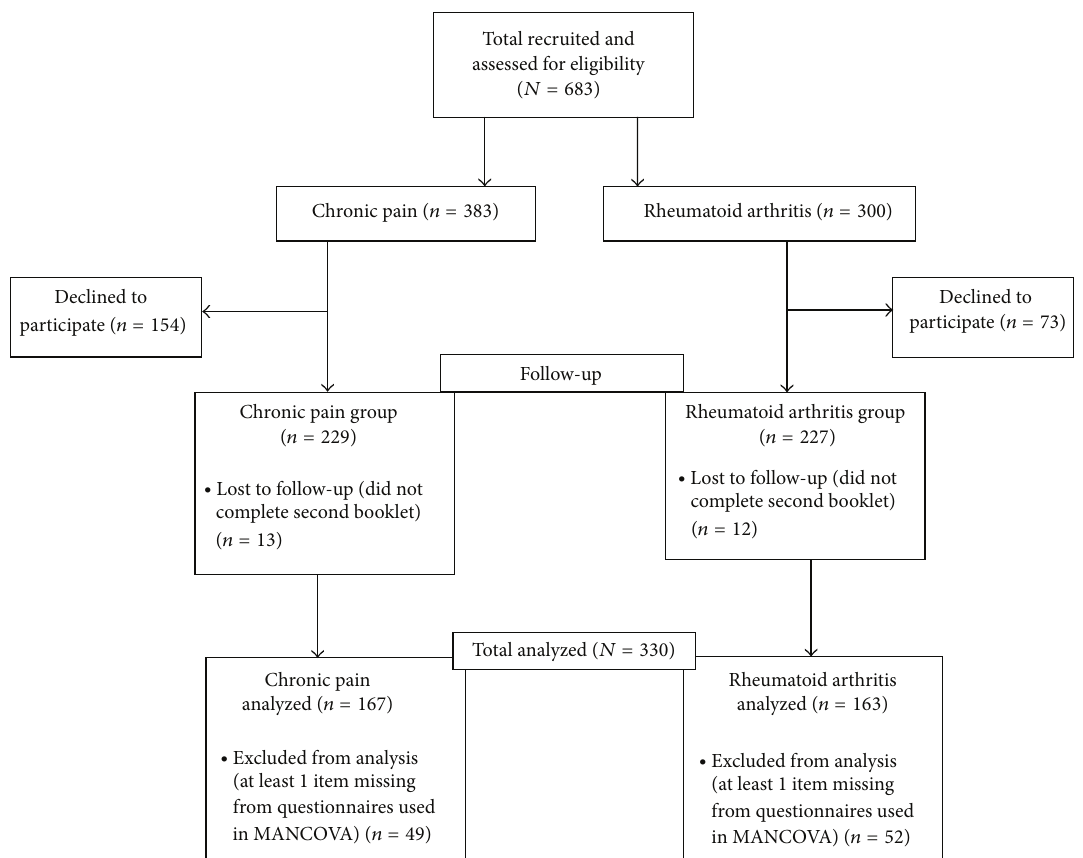
Figure 1: Participant flow